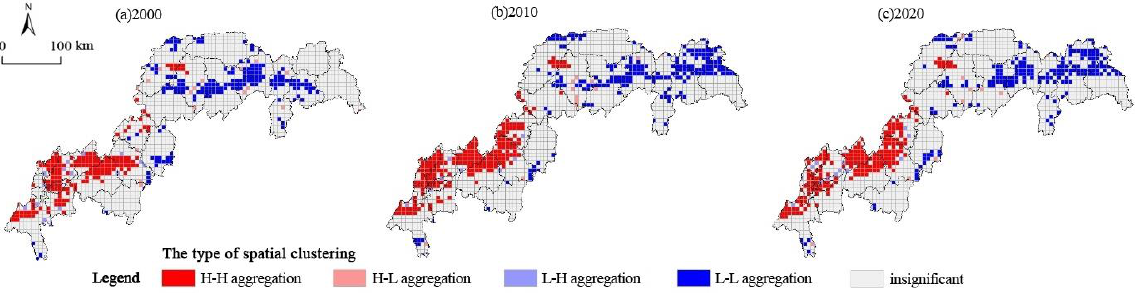
Figure 5. Local autocorrelation map of LER in the TGRR from 2000 to 2020.